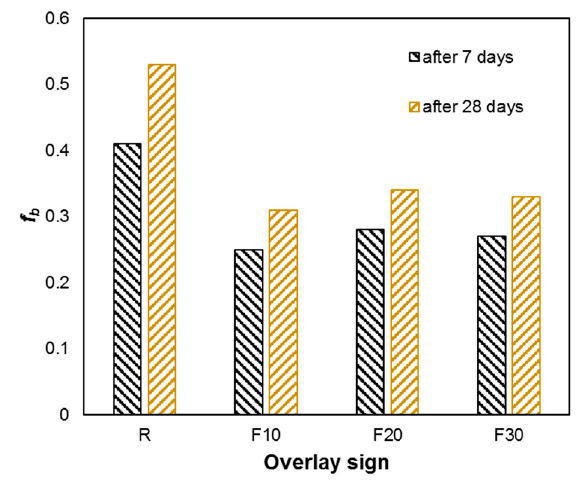
Figure 18. Influence of different amounts of quartz-feldspar powder for modifying overlay concrete on the pull-off adhesion f b between the overlay and concrete substrate (based on the results presented in Reference [74]).